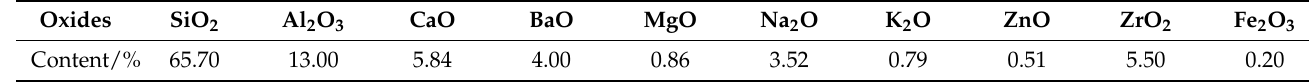
Table 1. Chemical composition of the transparent glaze